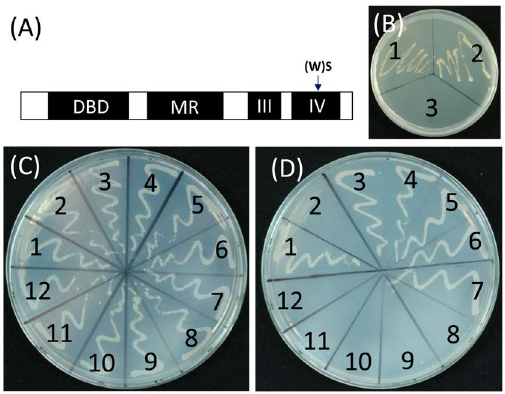
Figure 4. The W residue in Domain IV of OsARFs is crucial for the protein-protein interactions between Osiaa23 and OsARFs. (A) Diagram of conserved domains of OsARF protein. Black rectangles indicate four domains of OsARF, DBD and MR represent DNA binding Domain and middle region respectively, III and IV represent Domain III and Domain IV, which are similar to that of OsIAA. The substitution from W to S in Domain IV is indicated by arrow. (B) Self-activation test of OsARF16 and OsARF16(WS), which has an amino acid substitution from W to S in Domain IV. The transformed yeast was grown on medium without tryptophan, histidine and ade (SD -Trp/ -His/ -Ade). 1, OsARF16; 2, OsARF16(WS); 3, negative control. (C-D) Interactions between Osiaa23 and OsARFs, Osiaa23 and OsARF(WS)s in the yeast two-hybrid system. 1, positive control; 2, negative control; 3, Osiaa23 + OsARF6; 4, Osiaa23 + OsARF12; 5, Osiss23 + OsARF16; 6, Osiaa23 + OsARF17; 7, Osiaa23 + OsARF25; 8, Osiaa23 + OsARF6(WS); 9, Osiaa23 + OsARF12(WS); 10, Osiaa23 + OsARF16(WS); 11, Osiaa23 + OsARF17(WS); 12, Osiaa23 + OsARF25(WS). Yeast was grown on medium without leucine and tryptophan (SD –Leu/ -Trp) as a contral (C) and medium without leucine, tryptophan, histidine and ade (SD -Trp/ -Leu/ -Ade/ -His) to test the protein-protein interactions